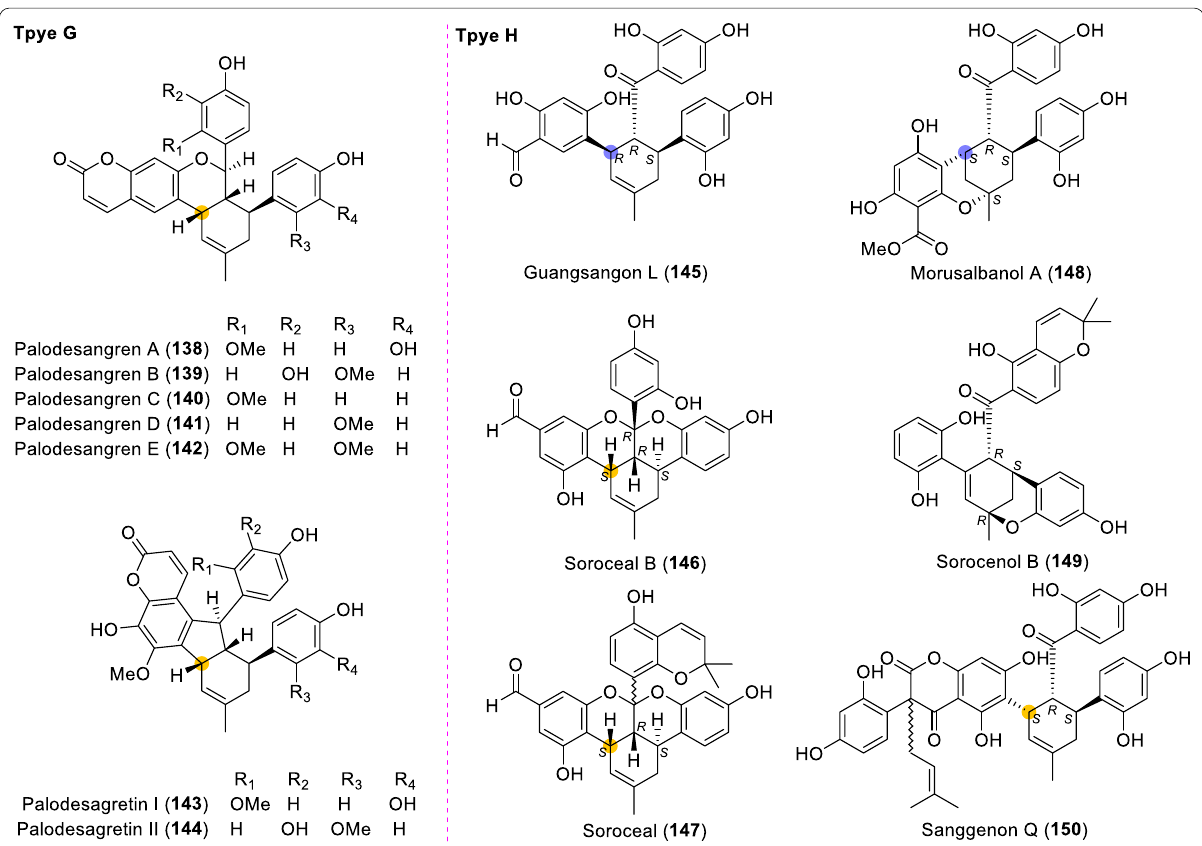
Fig. 10 Structures of dehydroprenylcoumarin type MDAAs (Type G) and simple or other dehydroprenylphenol type MDAAs (Type